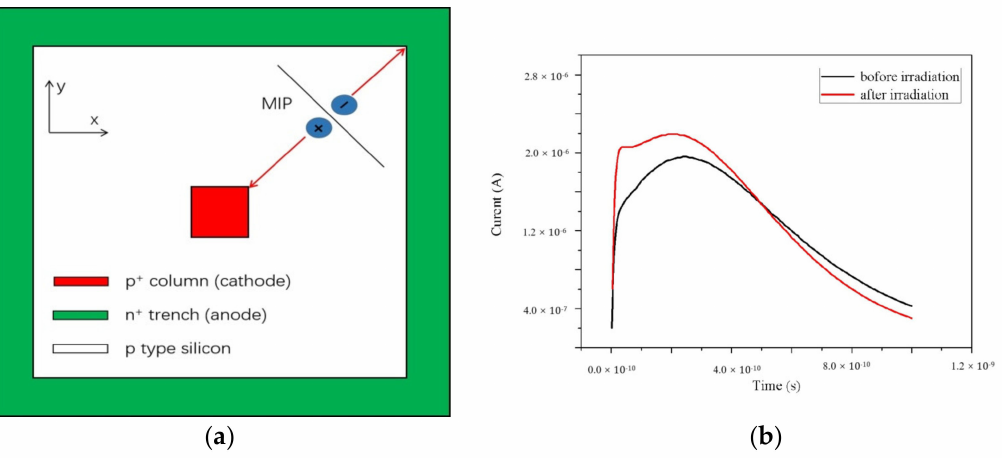
Figure 12. ( a ) Schematic diagram of MIP incidence. ( b ) The induced current curves with time before and during radiation with electrode spacing of 10 µ